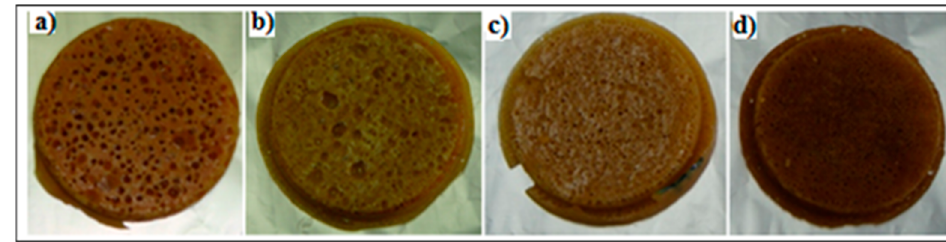
Figure 3. Digital images of ( a ) PULOA, ( b ) PULOB, ( c ) PUPFOA, and ( d ) PUPFOB.